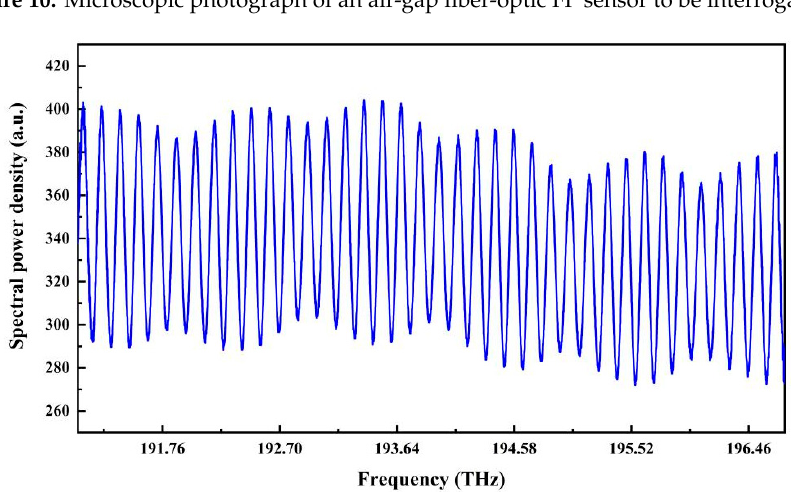
Figure 10. Microscopic photograph of an air-gap fiber-optic FP sensor to be interrogated. The reflection spectrum for a cavity length of 999.482 μ m is shown in Figure 11, which has multiple peaks in the spectrum.